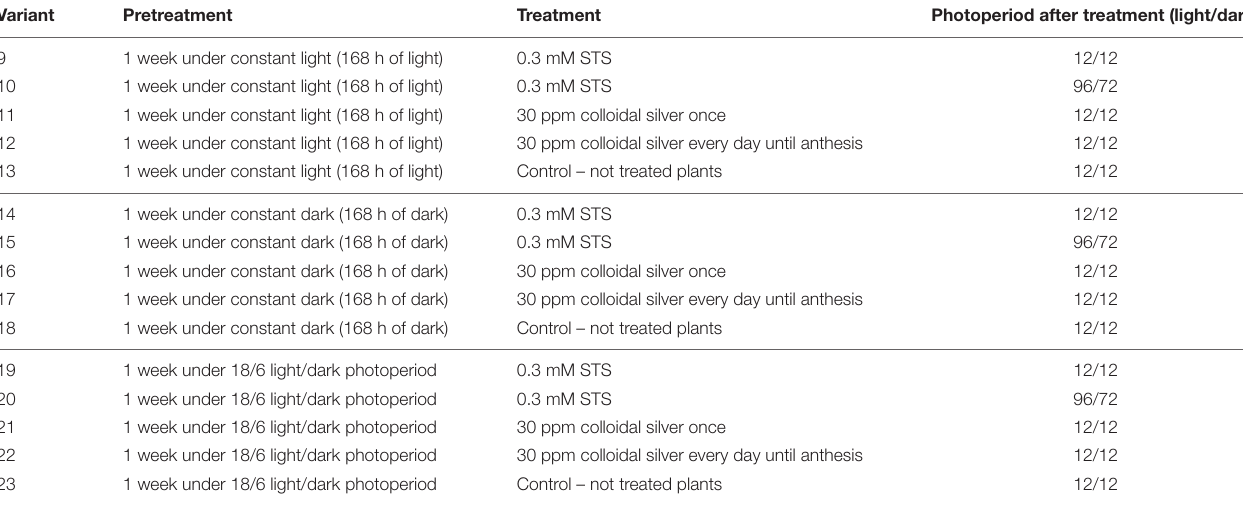
TABLE 2 | Combinations of pretreatments, treatments, and growing photoperiods used in the second experiment of male flowers induction.